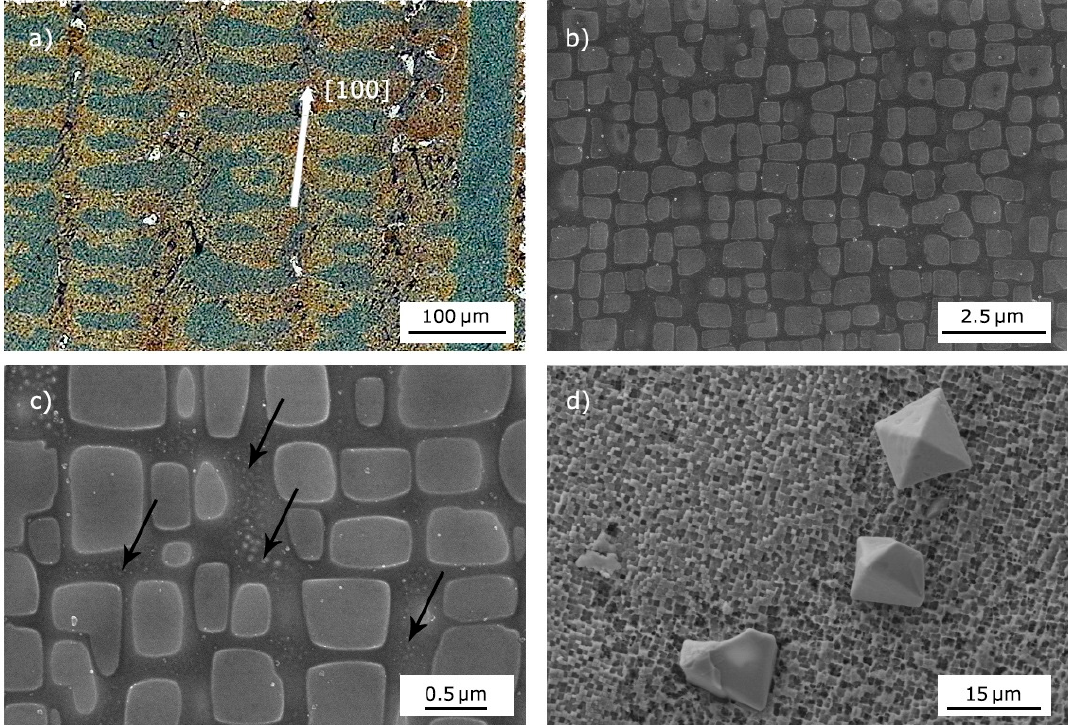
Figure 3. Directional structure of the alloy with [100] crystallographic direction parallel to the ingot axis ( a ); scanning electron microscope (SEM) micrographs (secondary electron imaging) of γ ’ cube particles in the matrix ( b ); secondary γ ’ particles (indicated by black arrows) of round shape and small size are observed in the channels between γ ’ cubes ( c ); faceted Ti-Ta carbides ( d ).